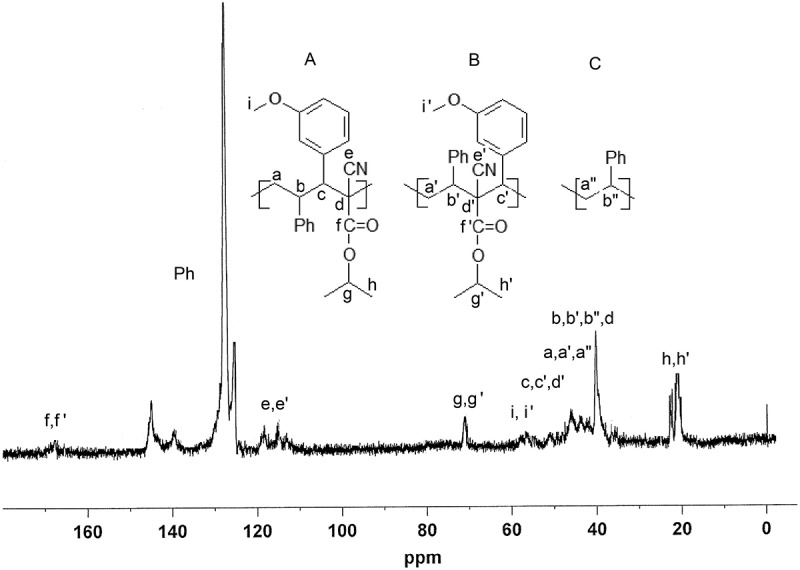
The 75 MHz 13C NMR spectrum of P(ST-co-ICPP) copolymer (R = 3-methoxy).